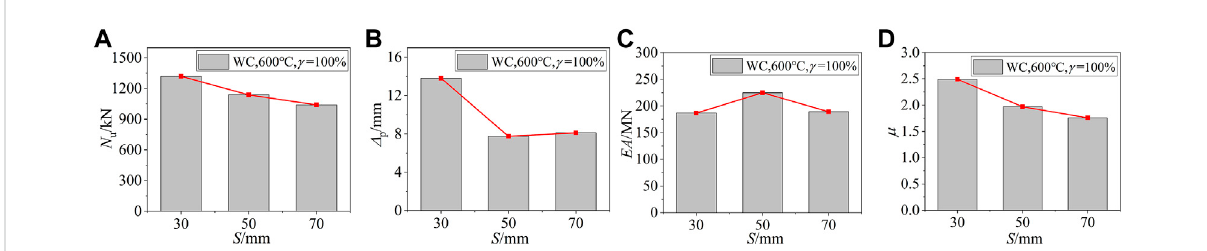
FIGURE 11 In fl uence of spacing on mechanical properties. (A) peak load; (B) peak displacement (C) initial stiffness (D) displacement ductility coef fi cient.